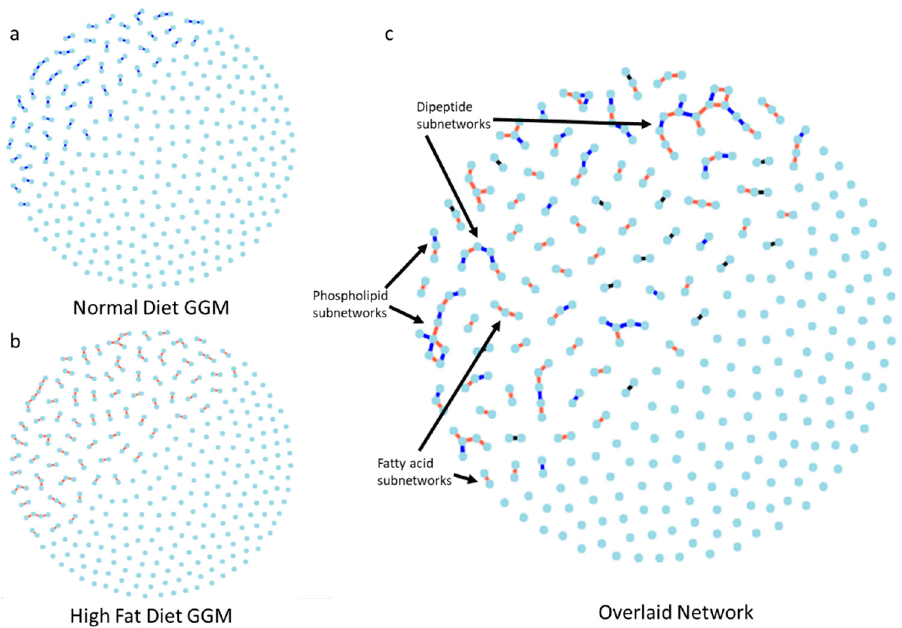
Figure 2. GGM showing relationships between metabolites in larvae fed with ( a ) Normal diet (blue) and ( b ) High-Fat diet (red) ( c ) The normal and high-fat diet networks are overlaid showing the unique normal diet model edges in blue, unique high-fat diet edges in red, and the common edges between the two in black (Interactive network visualization can be found in Supplemental Files: Figure_S2a_normal_ggm.html, Figure_S2b_highfat_ggm.html, and Figure_S2c_combined_ggm.html).